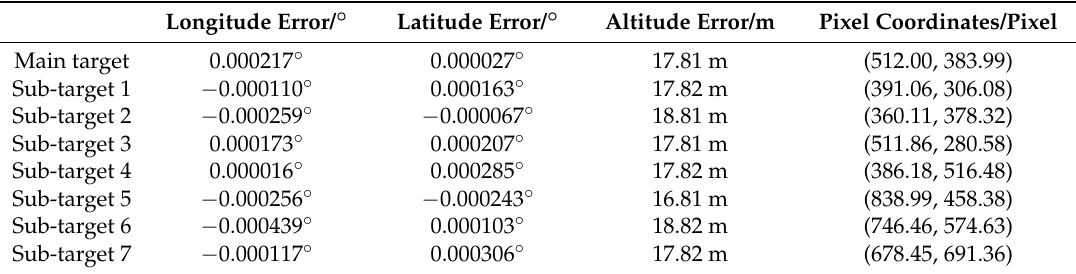
Table 5. Geo-location errors of multi-target after distortion